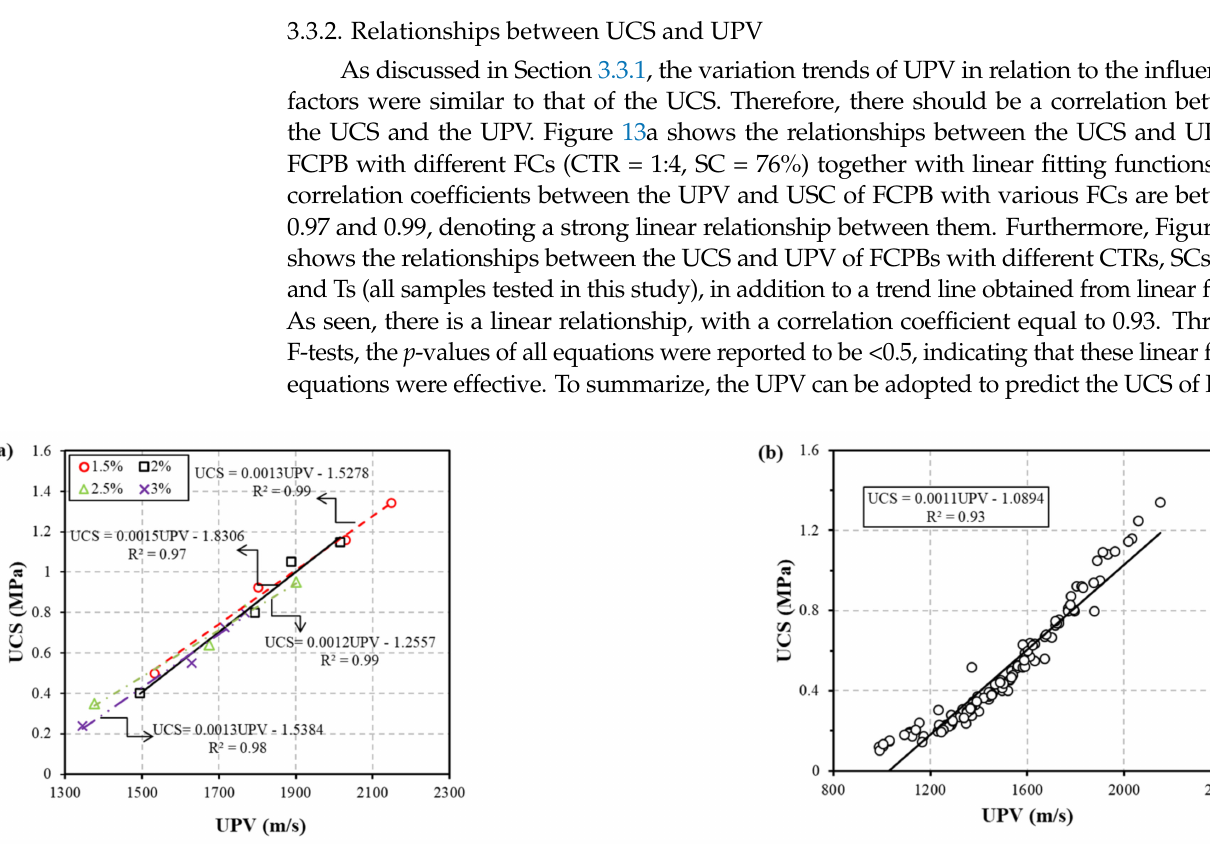
Figure 13. Relationships between UCS and UPV for ( a ) FCPB with various FCs (CTR = 1:4, SC = 76%) and ( b ) all FCPB